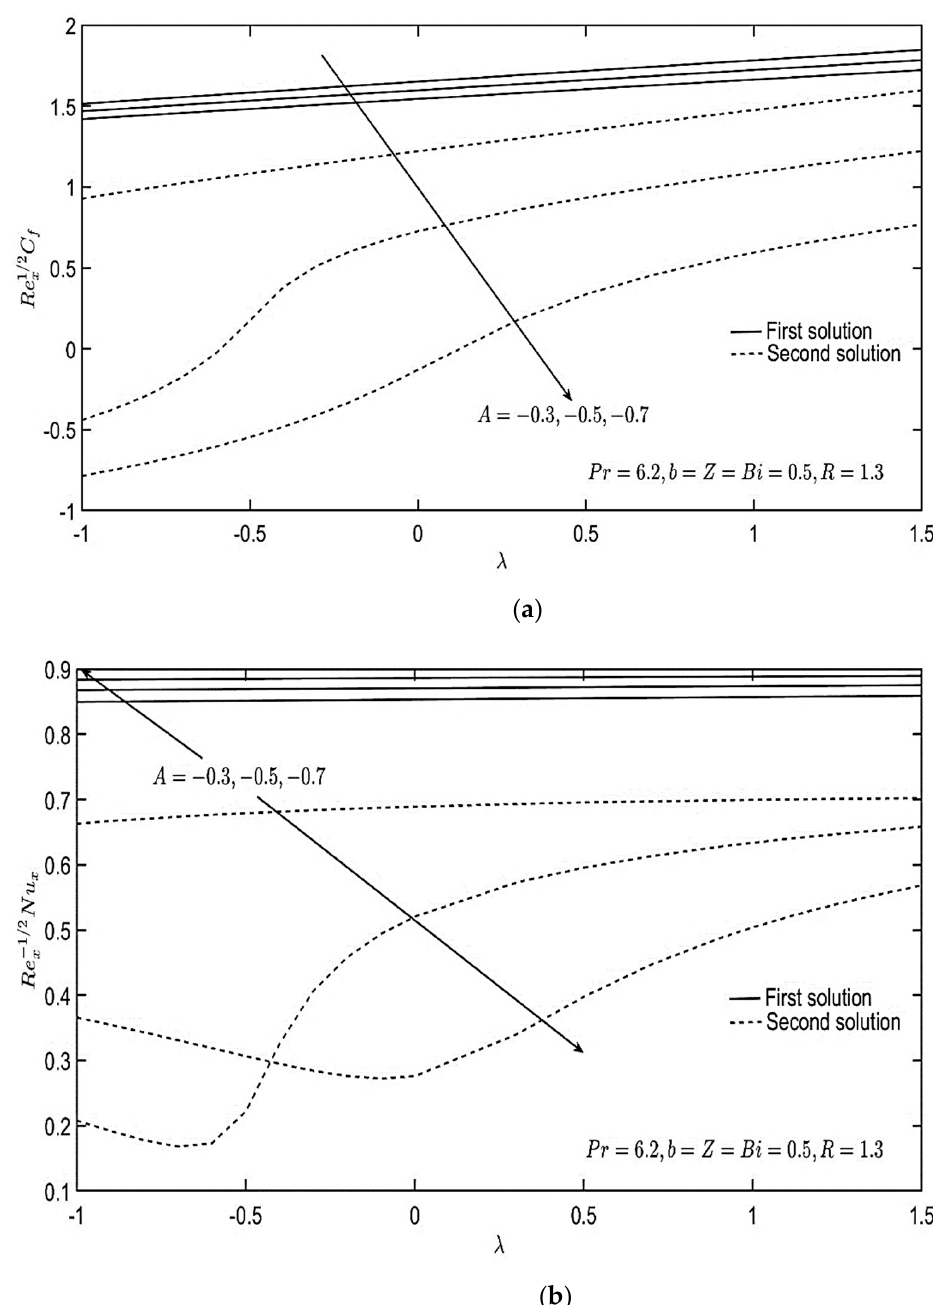
Figure 2. Plots of ( a ) Re 1/2 x C f and ( b ) Re − 1/2 x Nu x with various values of A and λ